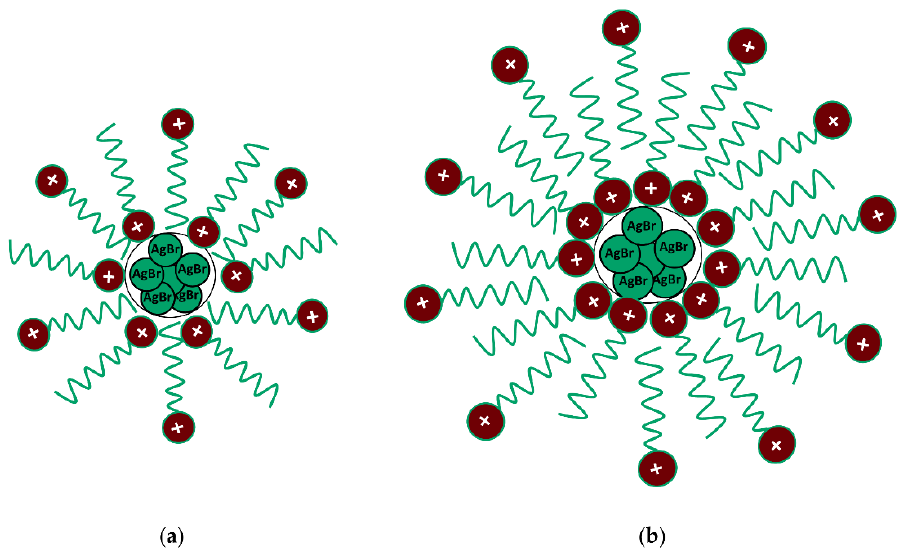
Figure 3. Schematic representation for ( a ) surfactant monolayer-protected AgBr nanoparticles and ( b ) AgBr nanoparticles stabilized by CTA + bilayer. Figure adapted with permission from reference [62]. Copyright 2012 American Chemical Society.